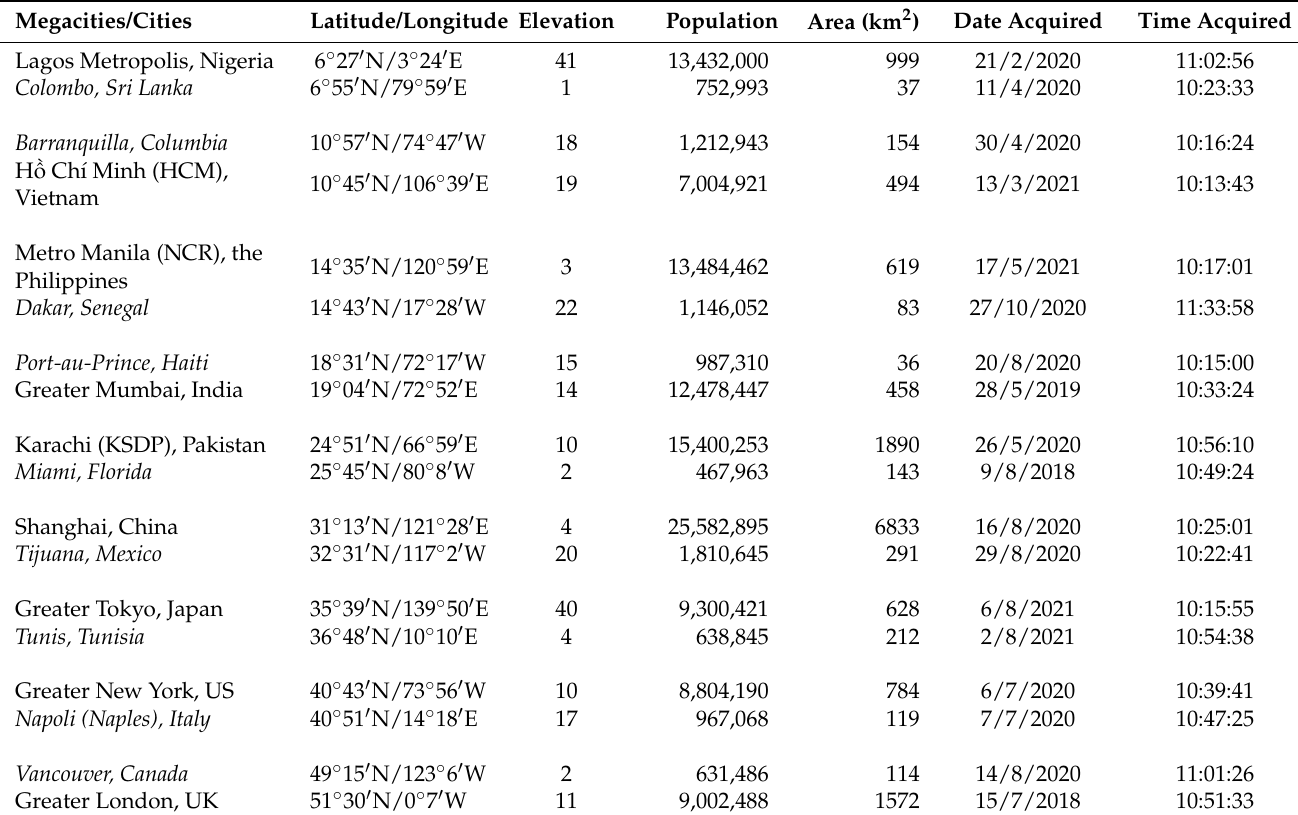
Table 1. List of cities and megacities with their latitudes/longitudes, elevations, populations, areas, and Landsat 8 date and time acquisition